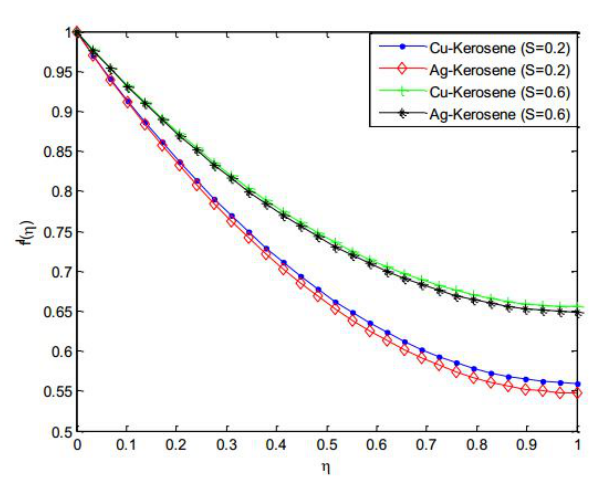
Figure 8. Effect of unsteadiness parameter on the fluid velocity distribution